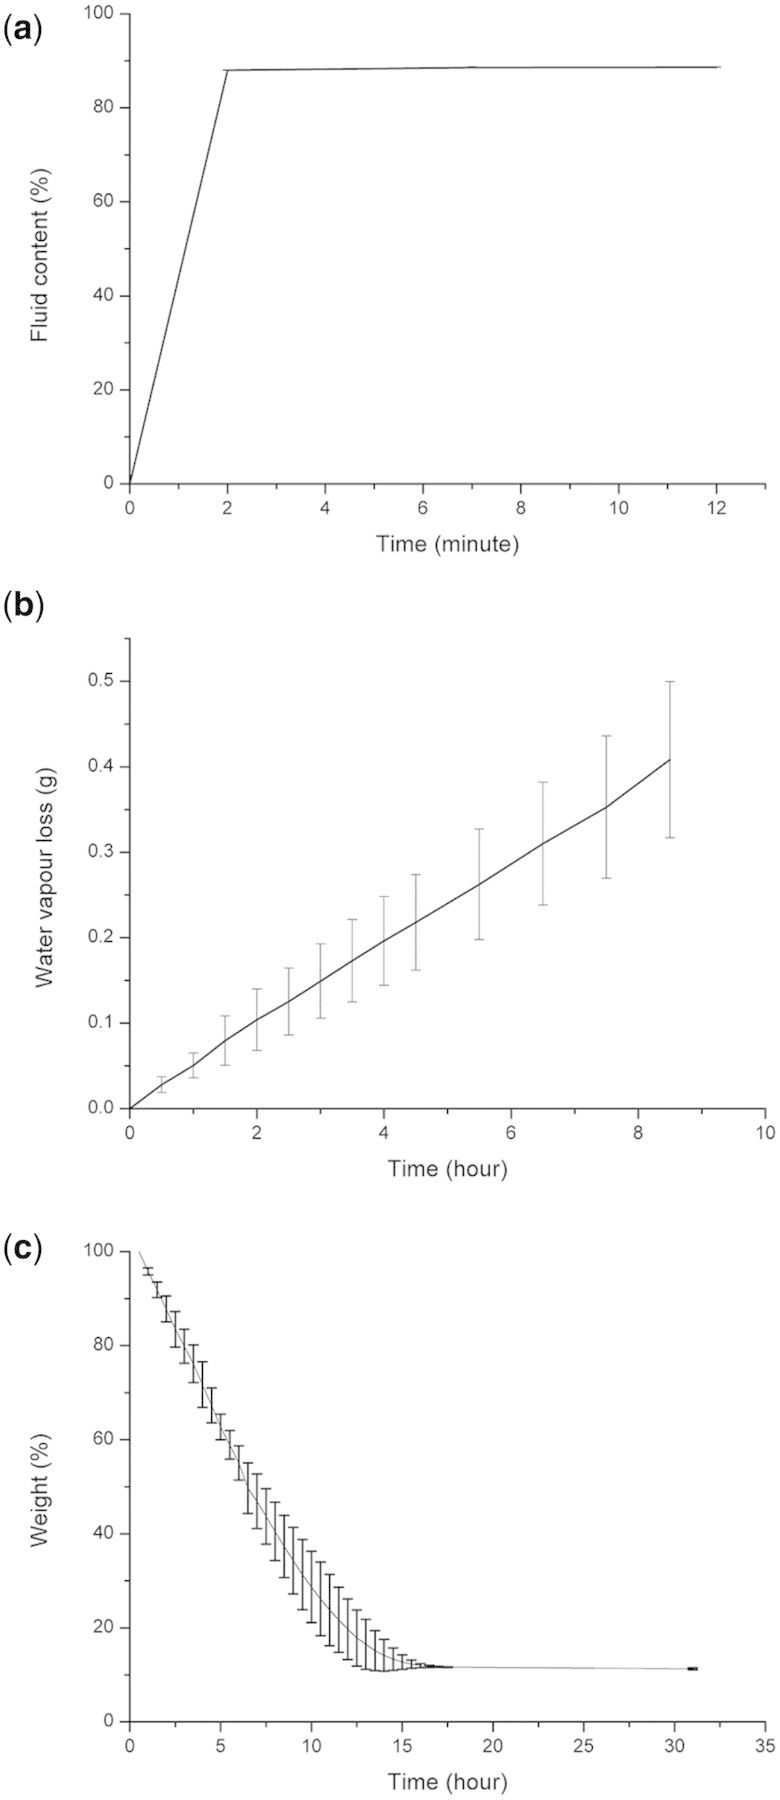
Water uptake measurements (a), water vapor transmitted across the samples (b) and water loss during dehydration (c)